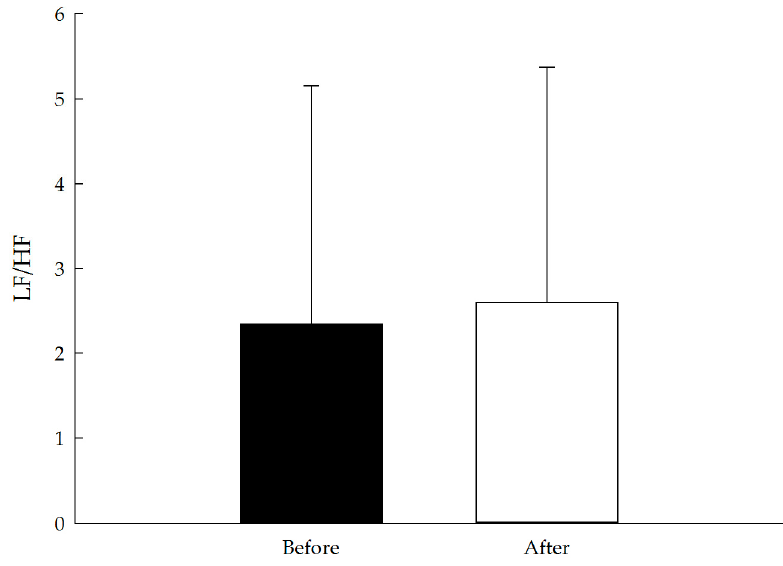
Figure 5. Effect of the short forest bathing program on LF/HF. N = 128, mean ± standard error. Paired-sample t test.